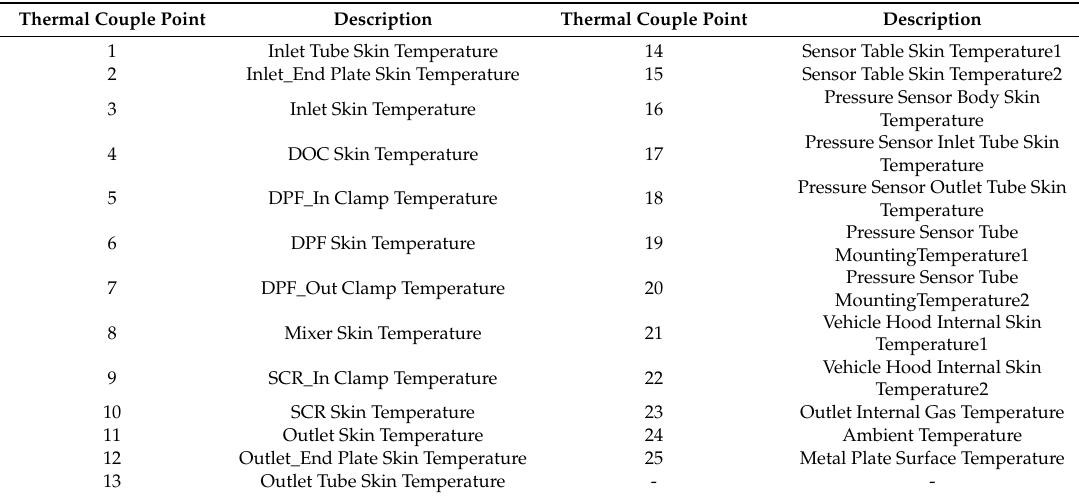
Figure 12. Experimental layout on vehicle. Table 1. Thermal couple description.